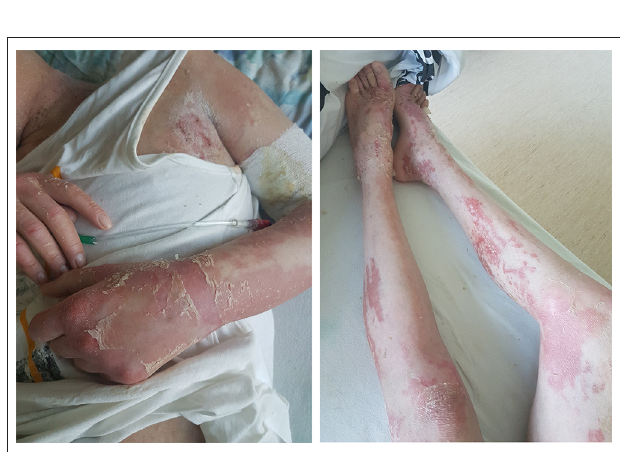
FIGURE 2 | Large erythematous plaques and intensive scaling on the patient’s